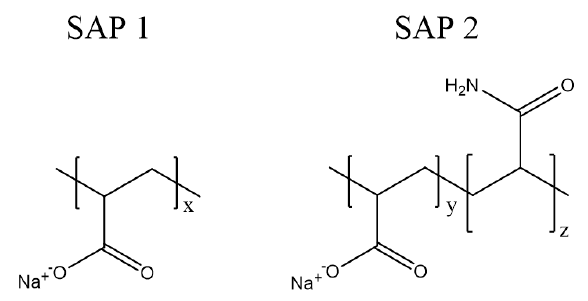
Figure 1. Molecular structure of pure polyacrylate (SAP 1) and poly(acrylate- co -acrylamide) (SAP 2).